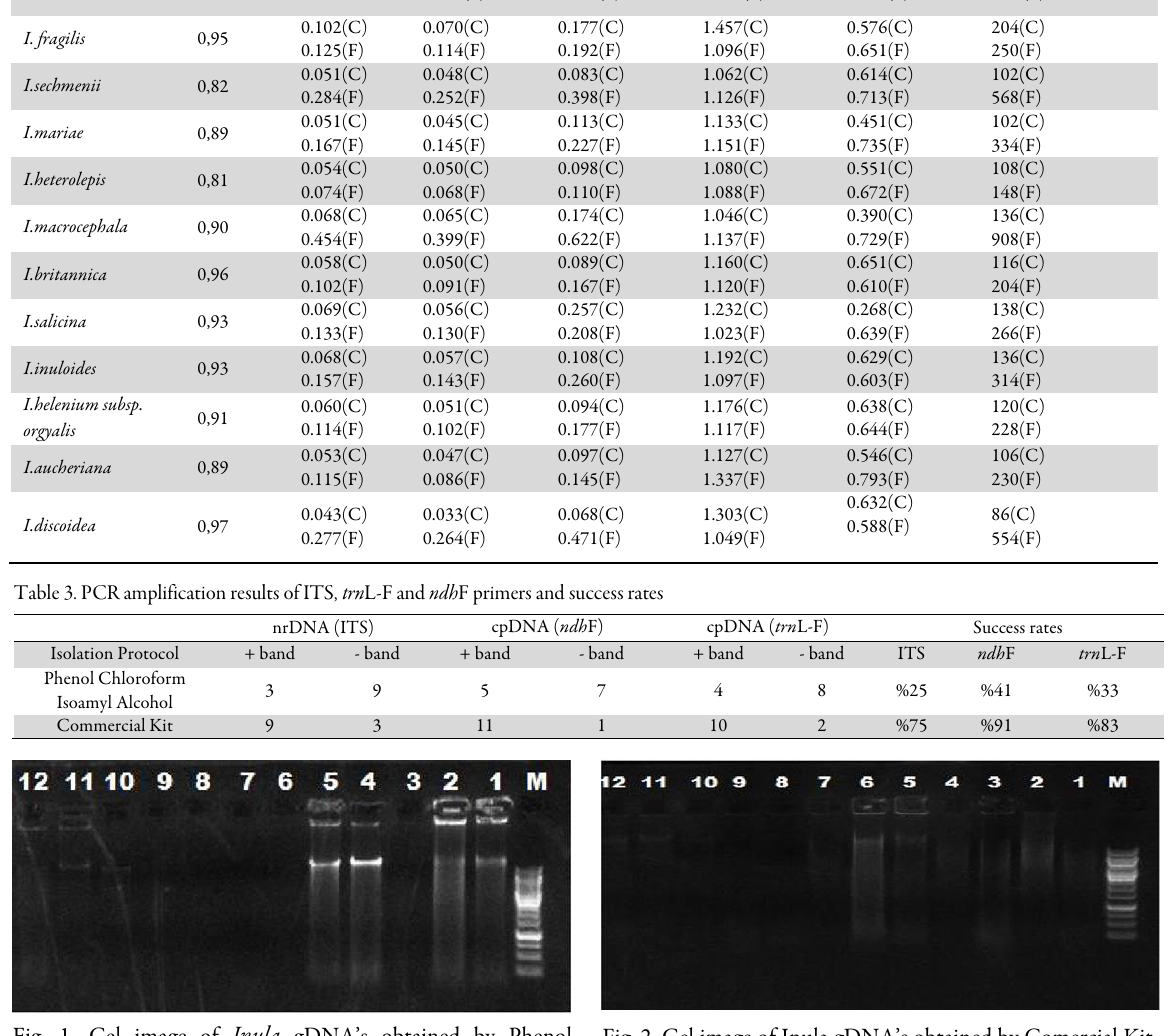
Fig. 2. Gel image of Inula gDNA’s obtained by Comercial Kit . 1. I. anatolica, 2. I. fragilis, 3. I. sechmenii, 4. I. mariae, 5. I. heterolepsis, 6. I. macrocephala, 7. I. britannica , 8. I. salicina, 9 . I. inuloides, 1 0 . I. helenium subsp. orgyalis, 11 . I. aucheriana, 12 . I.